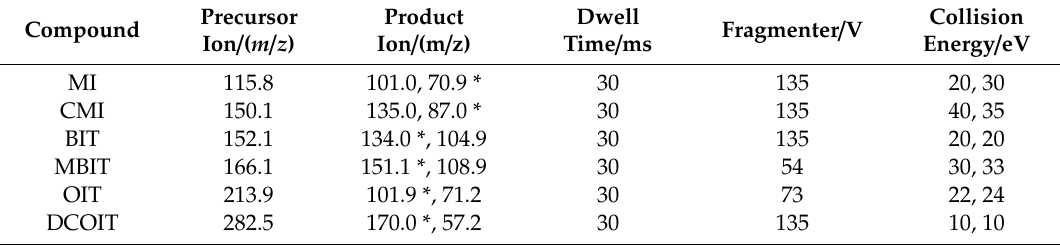
Table 4. The optimized MRM parameters for six targeted